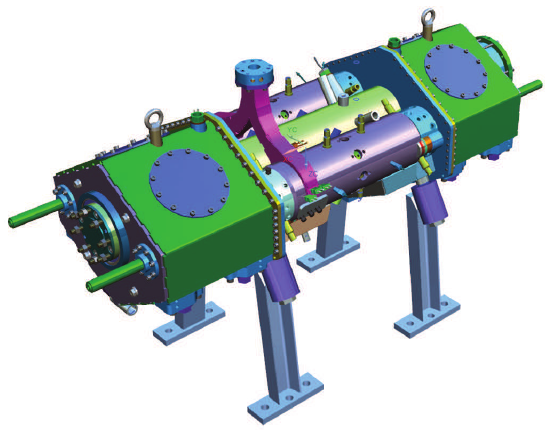
Fig. 2. PAMAR-4 CAD model without auxiliary equipment